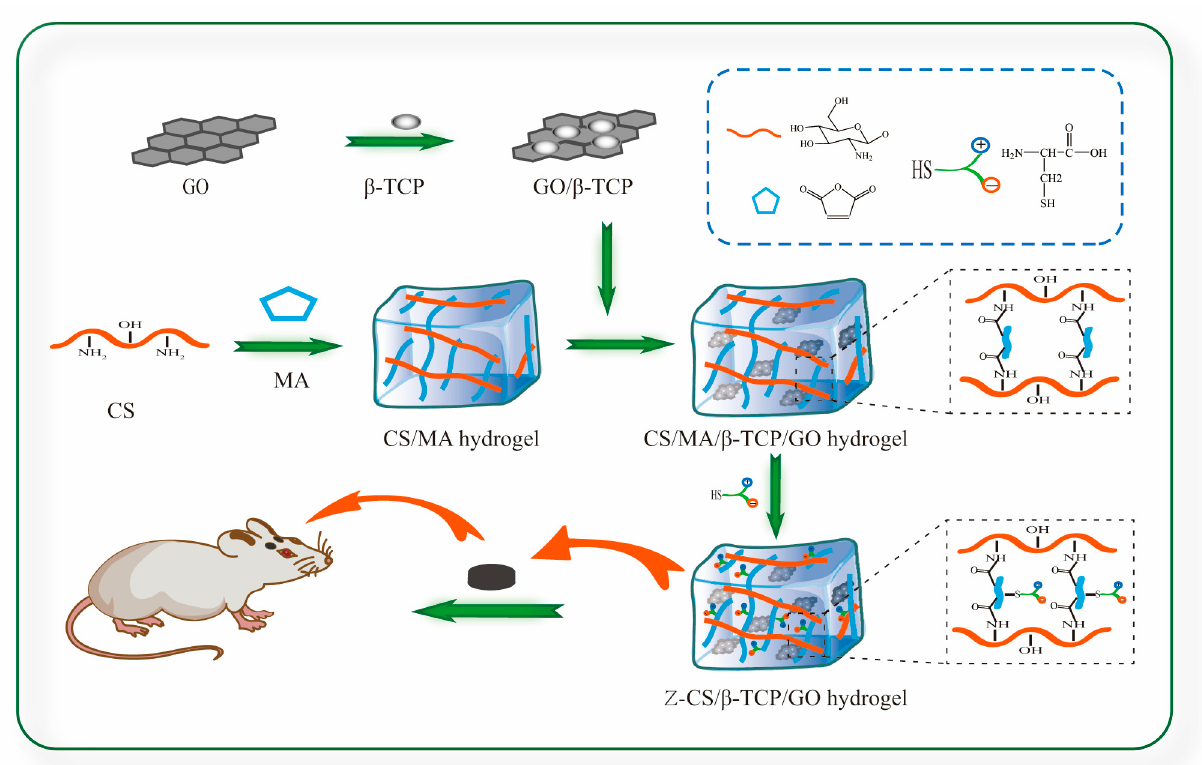
Figure 7. Scheme of the synthetic zwitterionic hydrogel.